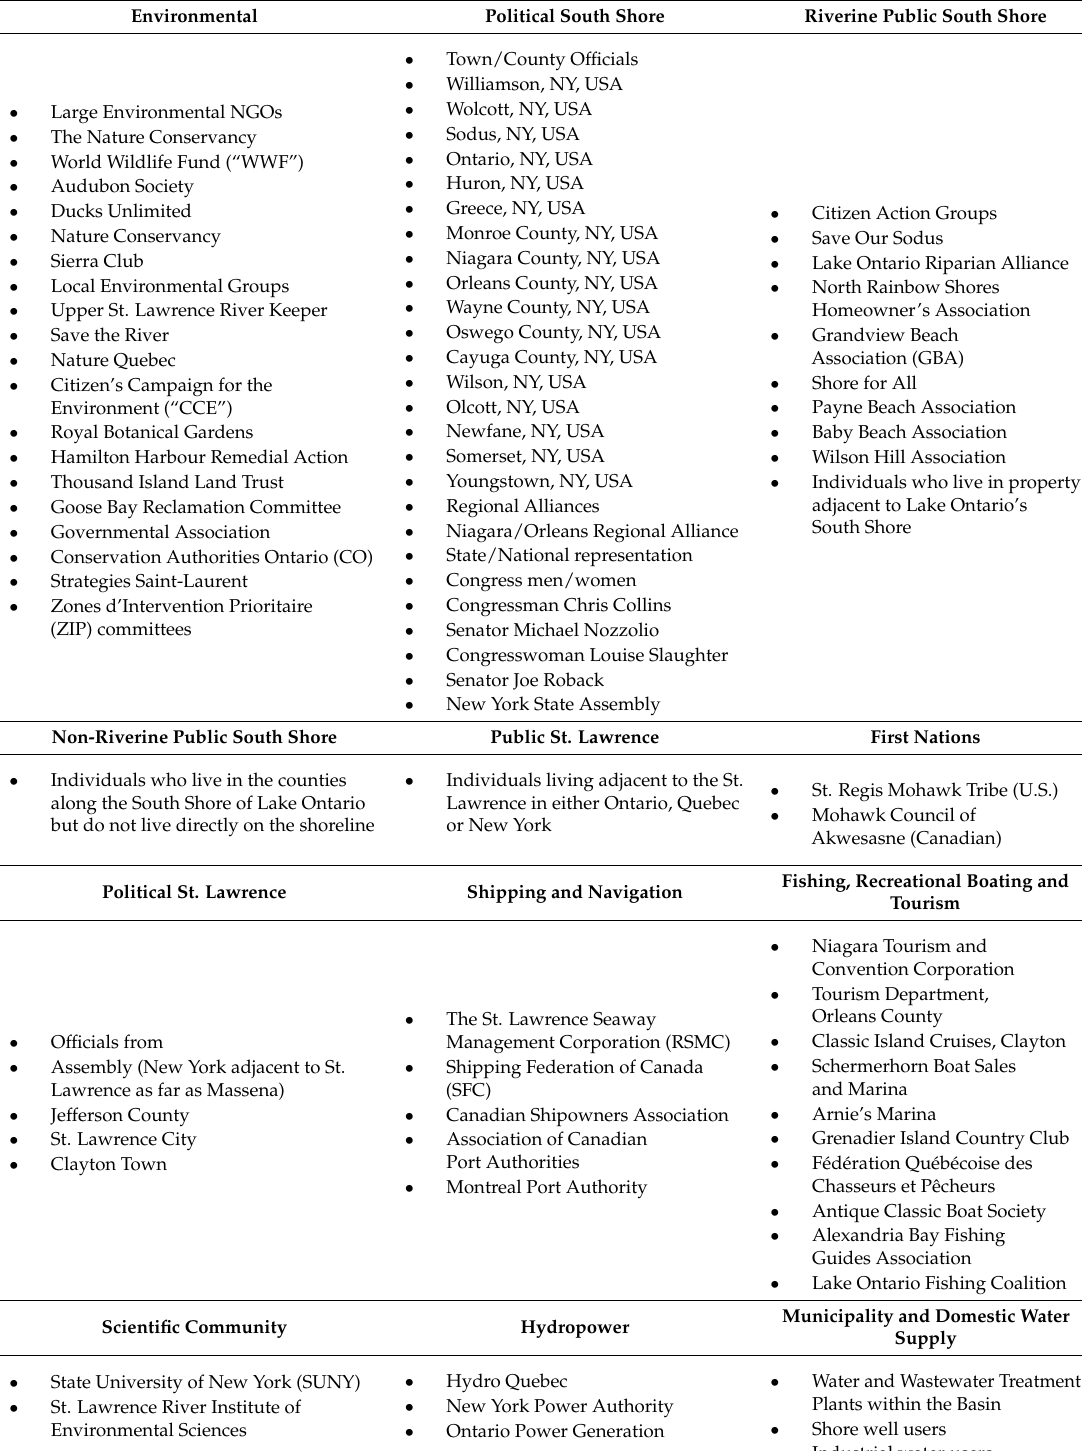
Table 2. Final classification of speakers participating in the 2013 public and technical